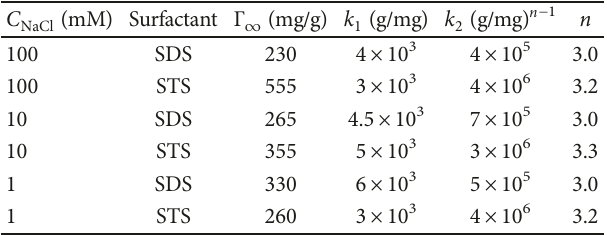
Table 1: The fi t parameters for the SDS and STS adsorption isotherms onto γ -Al O at di ff erent NaCl concentrations (pH4). 2 3 The maximum adsorbed amount Γ ∞ , the equilibrium constants k fi rst step and second step, respectively, and k 1 and 2 for the n the aggregation number of hemimicelle of SDS and STS molecules.